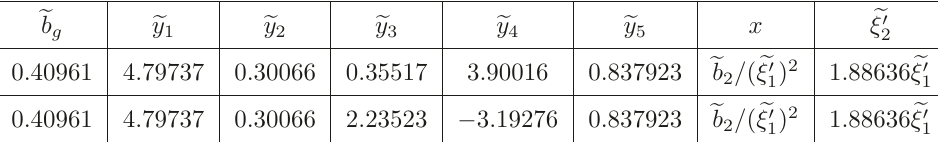
Table 2 . Curved Space UVFPs for SO(